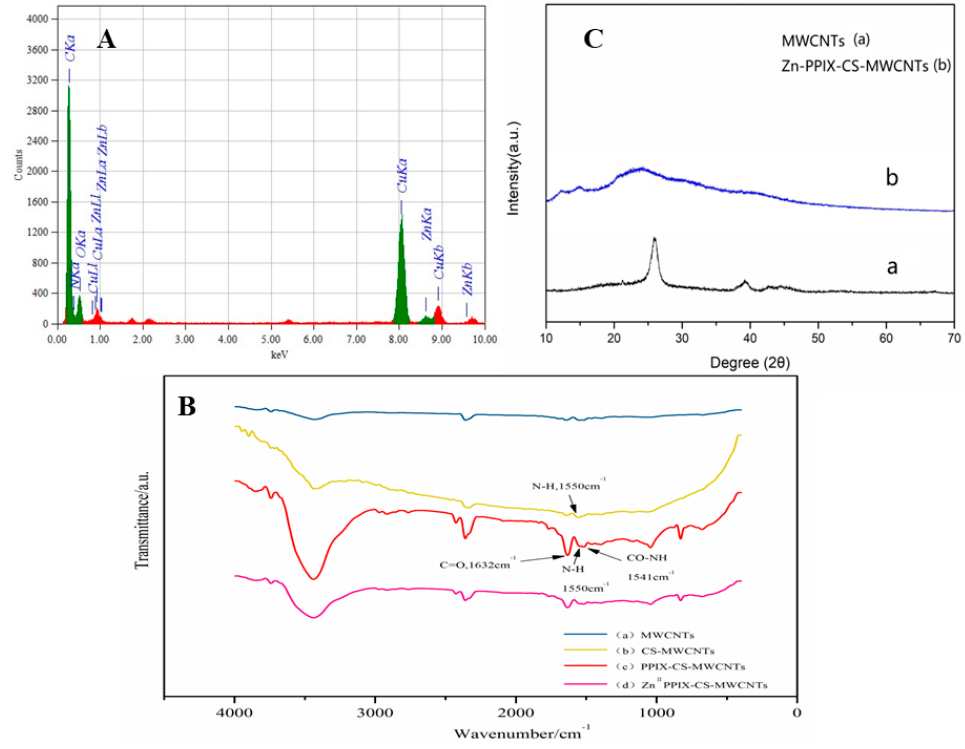
Figure 3. ( A ) EDX spectrum of Zn–PPIX–CS–MWCNTs. ( B ) FTIR spectra of MWCNTs ( a ), CS– MWCNTs ( b ), PPIX–CS–MWCNTs ( c ), and Zn–PPIX–CS–MWCNTs (d). ( C ) XRD patterns of MWCNTs ( a ) and Zn–PPIX–CS–MWCNTs ( b ).